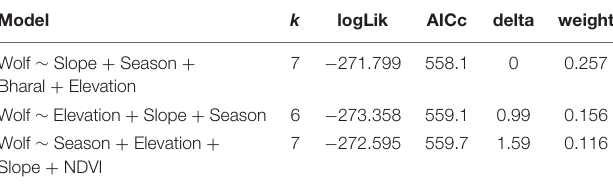
TABLE 5 | Top three candidate models for examining the relationship between the relative abundance of the woolly wolf, habitat, season, and seasonal anthropogenic pressures in the Nelang valley of the Gangotri National Park, Uttarakhand, India, with Akaike information criterion of each model adjusted for small sample size (AICc), number of parameters (k), the difference in AICc from the best-performing model ( (cid:49) AICc), and Akaike